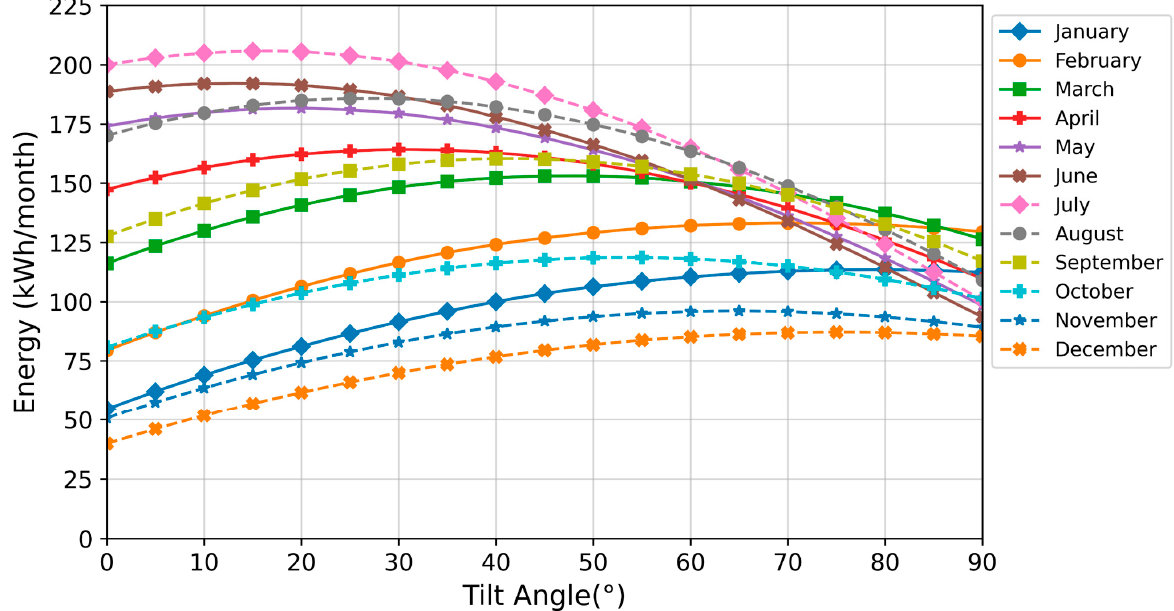
Figure 9. Monthly energy production during the first operational year of the 1200 W bifacial PV system for different tilt angles in London, Ontario.